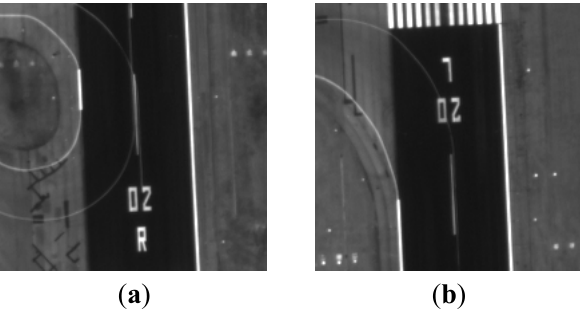
Figure 5. Two experimental regions cropped from Figure 3. ( a ) Image1; ( b )